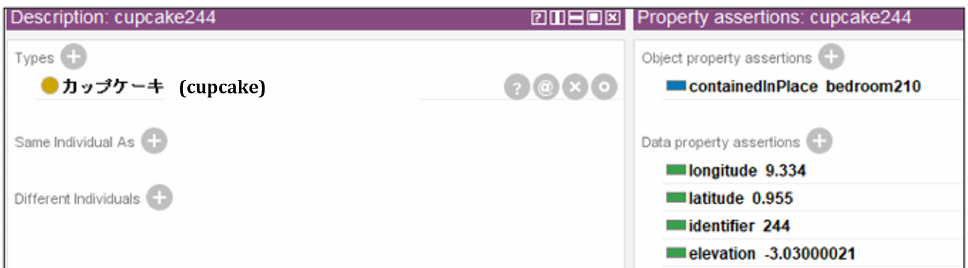
Figure 11. Part of class hierarchy.